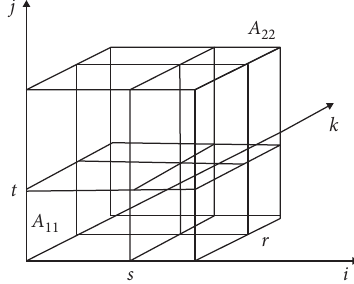
Figure 1: 3D space schematic diagram of the